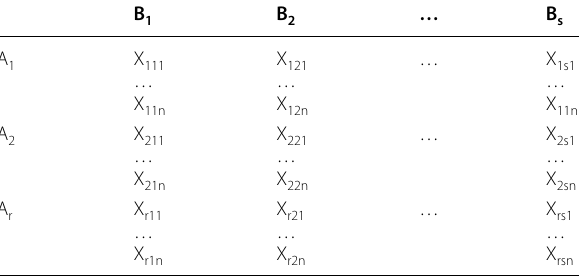
Table 4 Datasheet of the two‑factor equal‑repeated variance analysis. B